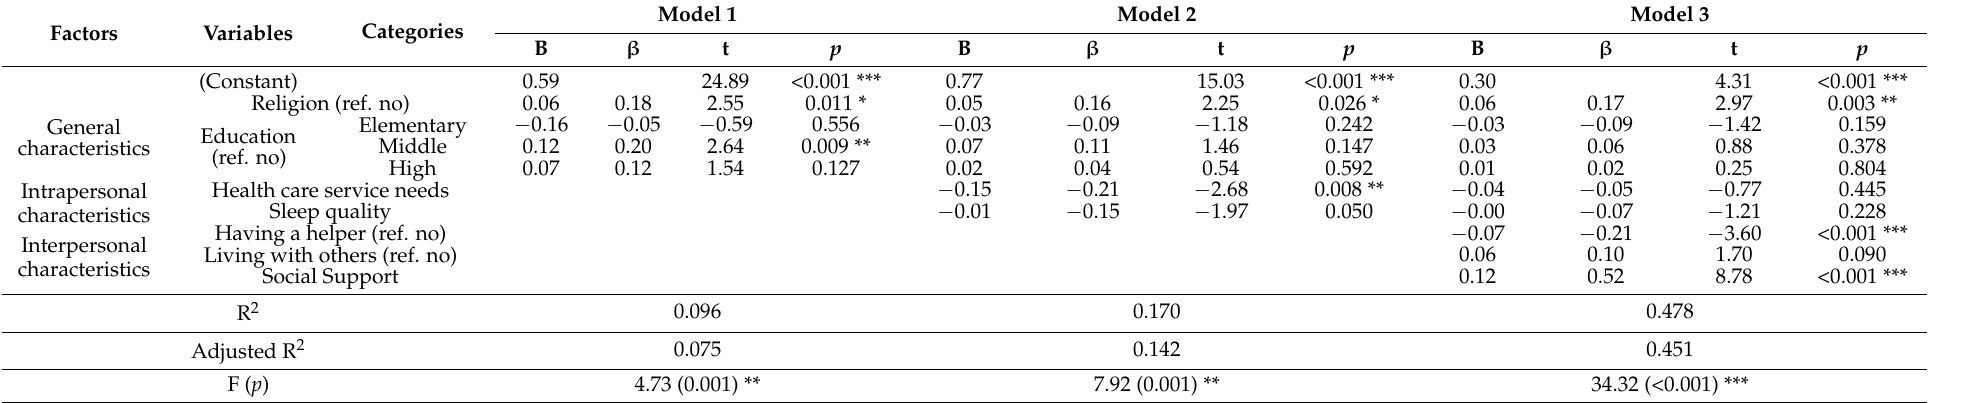
Table 3. Effects of Participant’s General, Intrapersonal, Interpersonal Characteristics on Health-Related Quality of Life ( N =